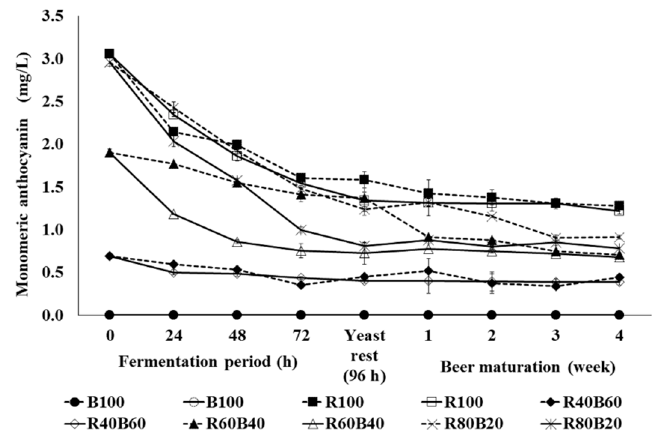
Figure 4. Monomeric anthocyanin kinetics in fermented composite wort (B100, R40B60, R60B40, R80B20, and R100) by the two yeast strains BRY 97 ( S . cerevisiae ), POF − ; and Belle Saison ( S . cerevisiae var . diastaticus ), POF + .